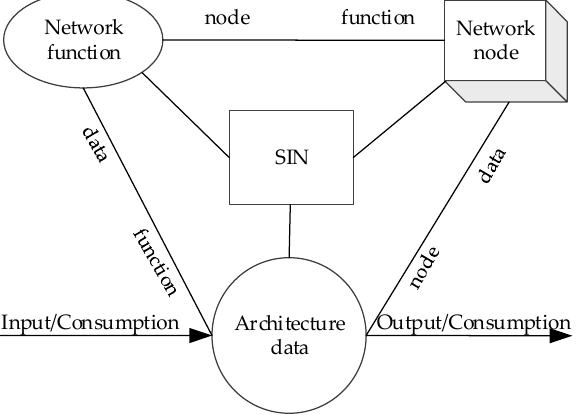
Figure 2. SIN architecture object diagram.